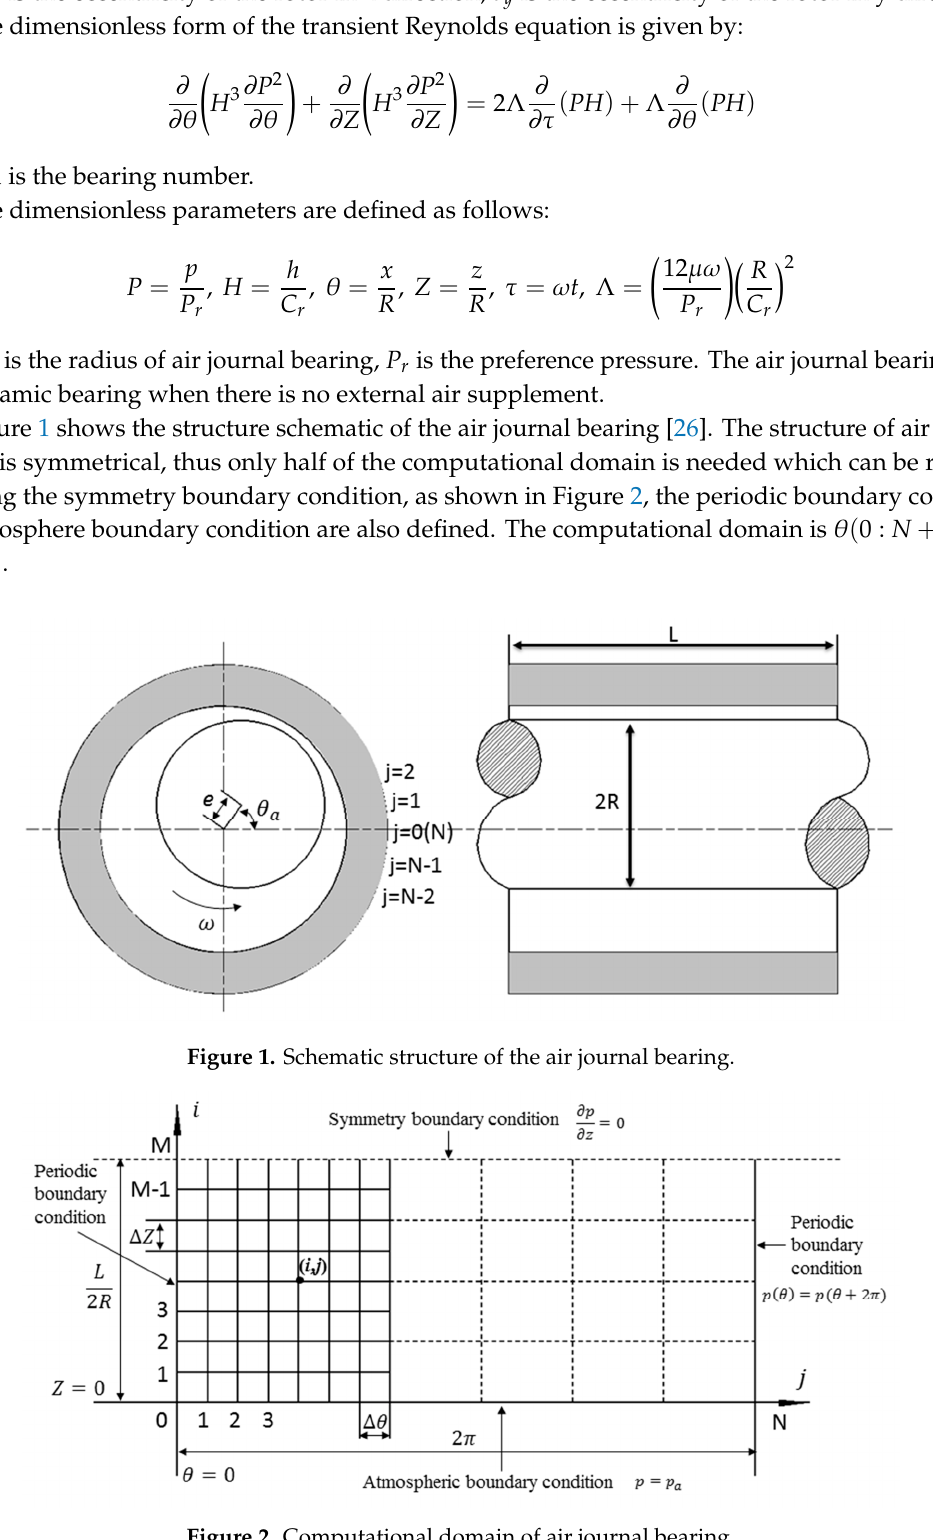
Figure 2. Computational domain of air journal bearing.